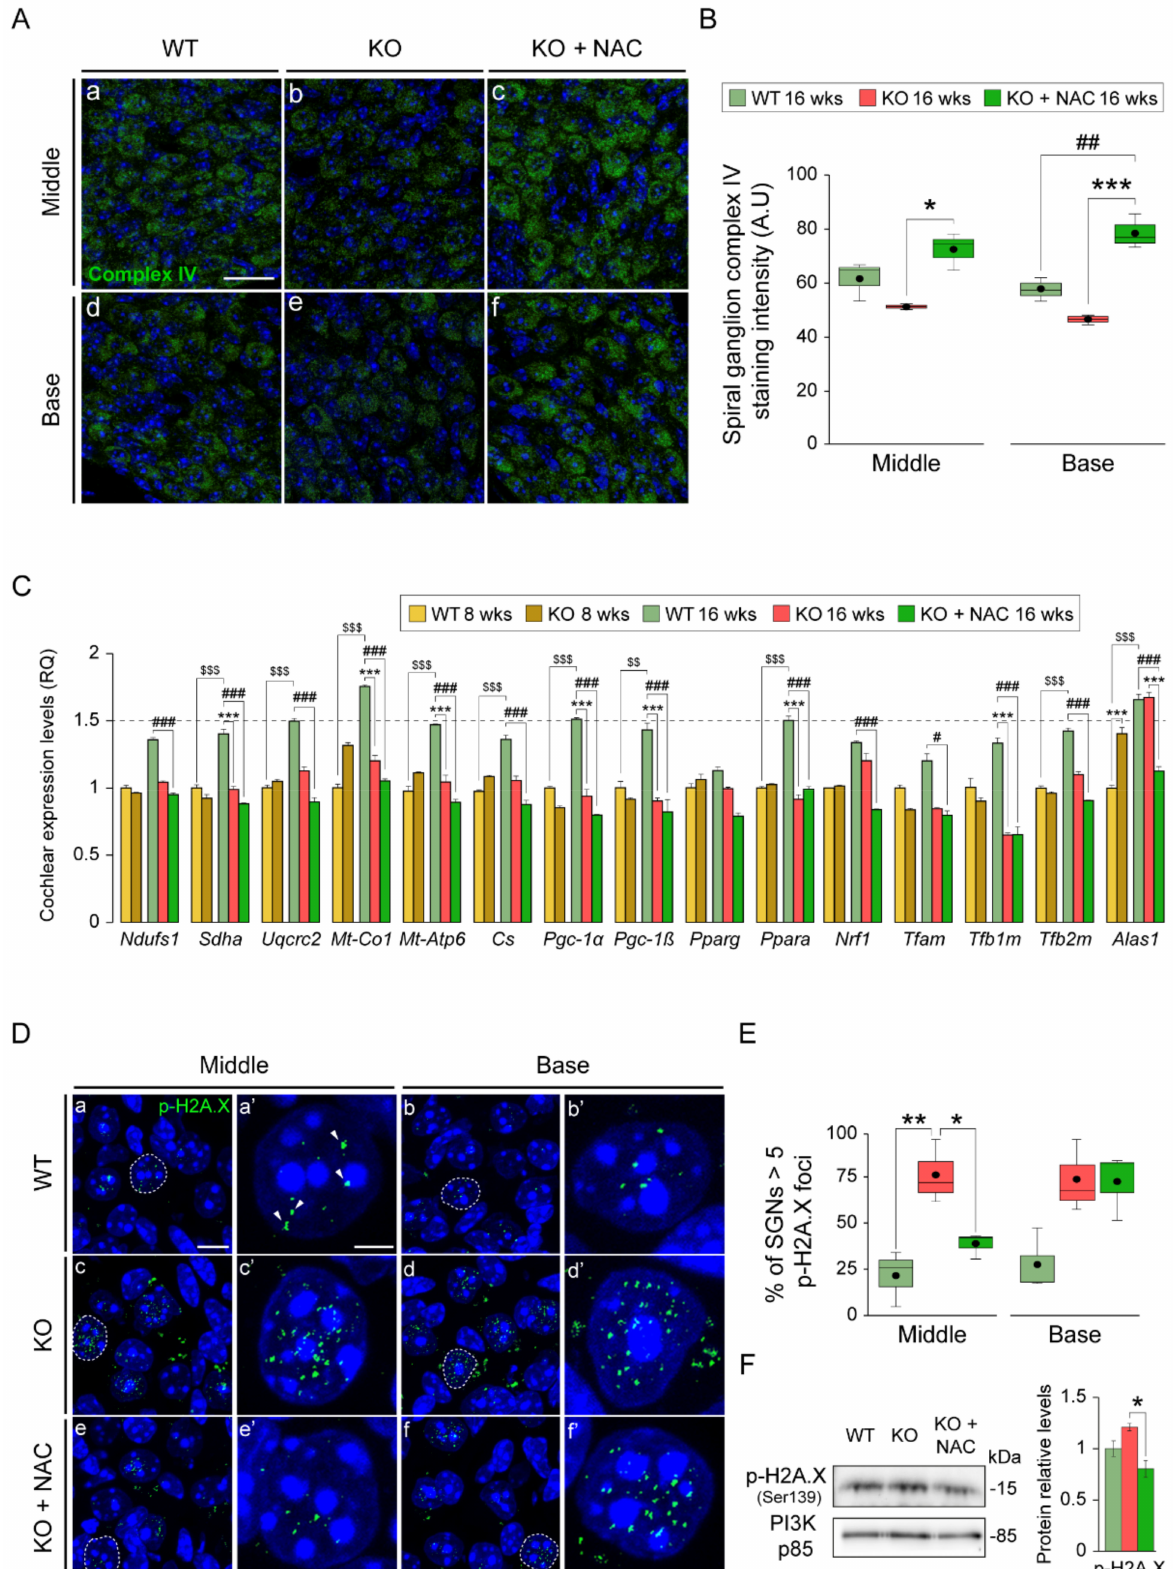
Figure 5. N-acetylcysteine administration preserves mitochondria and reduces DNA damage foci in Dusp1 − / − spiral ganglion neurons. ( A ) Representative basal and middle turn cochlear spiral ganglion (SG) cross-cryosections of 16-week-old wild-type (WT), Dusp1 knock-out (KO) and NAC-treated Dusp1 KO mice immunolabeled for mitochondrial complex IV (green). Scale bar: 20 µ m in a. ( B ) Positive stained area intensity of the SG was quantified in 3 mice per condition in at